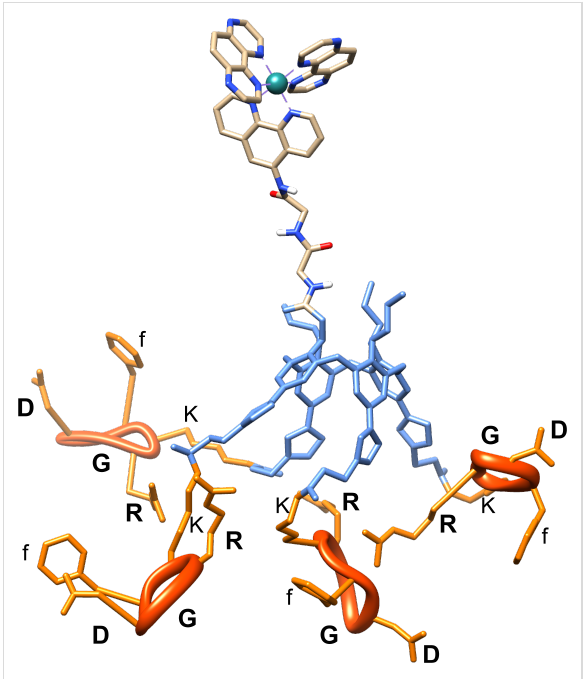
Figure 2: MD snapshot showing an optimized model of conjugate 9 . RGDfK units are depicted in orange ribbons, the calixarene is in blue and the Ru complex is colored by atom